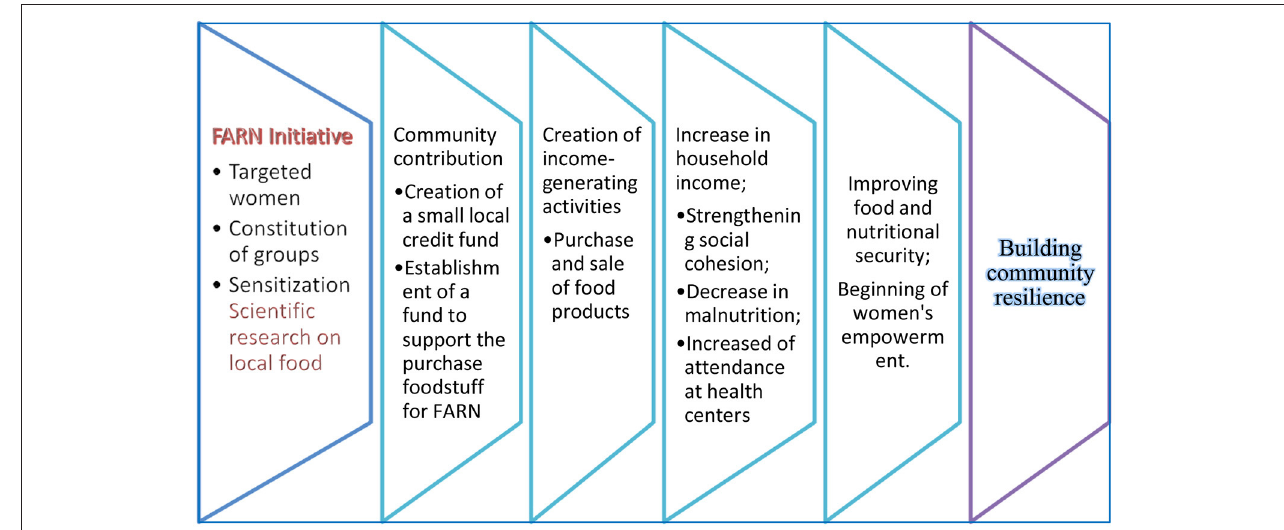
FIGURE 2 | Link between Learning and Nutritional Rehabilitation Homes (FARN) and building